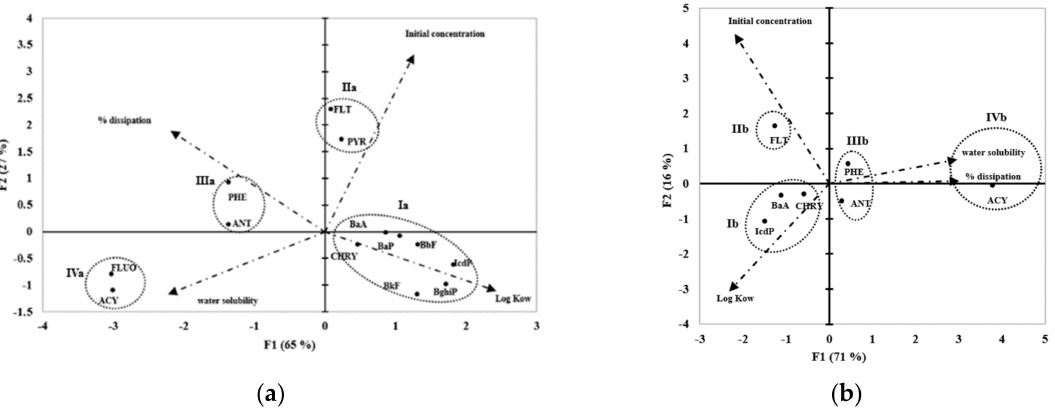
Figure 2. Principal component analysis (PCA) showing the two first axes (axes F1 and F2 of total variance) for the PAH distribution. ( a ): BA4 treatment; ( b ): NA treatment. The PCA was performed on four PAH parameters: % dissipation, PAH initial concentration, water solubility, and Log Kow. For PAH abbreviations, see Table 3. Only PAH types with significant dissipation are shown. Table 3. Selected physical and chemical properties of the 16 US EPA